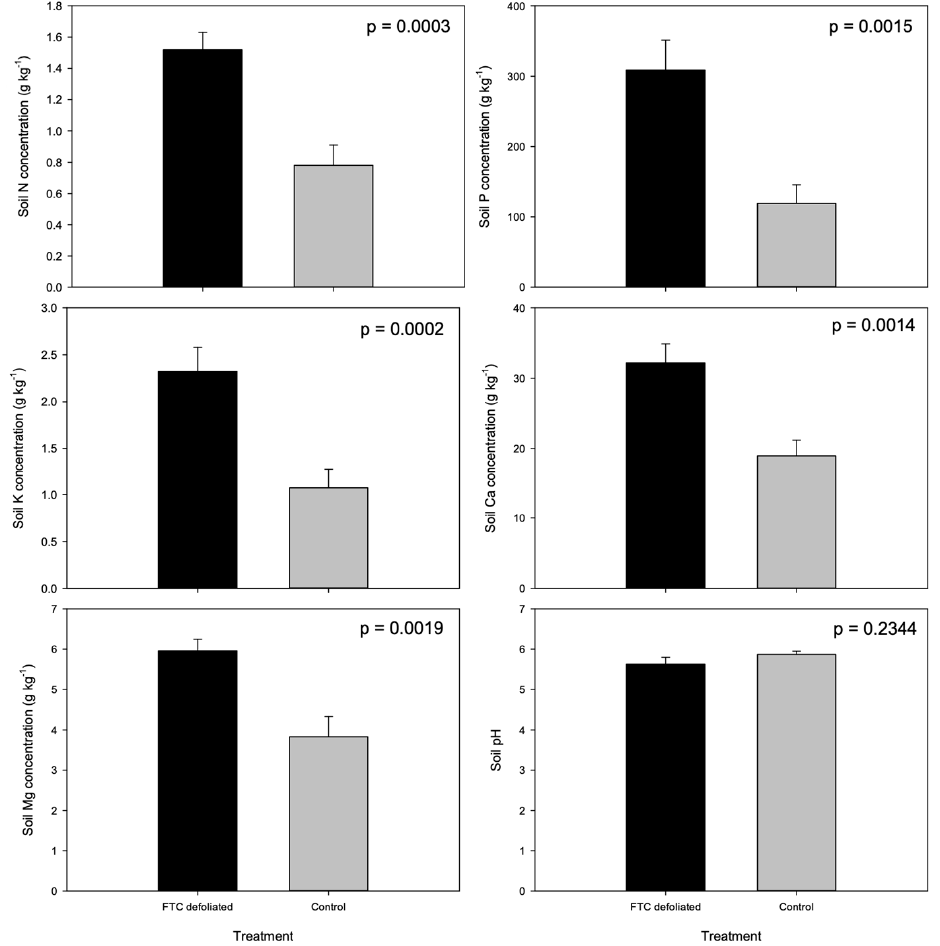
Figure A1. Soil chemistry analysis by Centre de Foresterie des Laurentides, Service Canadien des for ê ts, Ressources naturelles Canada in 2017. N, P, K, Ca, Mg total and pH were measured for the top 5 cm of soil located beneath defoliated and undefoliated (control) trees in 2017; this corresponds to the organic layer. Samples were dried at 70 ◦ C for 48 h. The pH was determined in distilled water with Orion 2-star pH Benchtop Meter (Thermo Fisher Scientific Inc., Waltham, MA, USA), total C and N with wet digestion and analyzed with a LECO CNS-2000 (LECO Corporation, St. Joseph, MI, USA) and nutrients by ICP-MS (Perkin Elmer OES OPTIMA 7300 DV, Perkin-Elmer, Inc., Shelton, CT, USA)